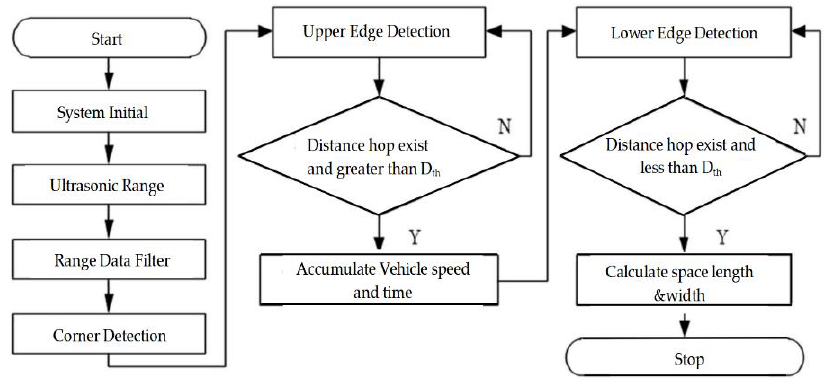
Figure 2. The structure of parking spot detection algorithm. Edge detection, which is crucial for the accuracy of parking spot detection, comprises upper edge detection and lower edge detection. In the case of parallel parking, the threshold of distance hop, which includes the hop threshold of the upper H upper and lower H lower edges, is calculated based on the threshold of the ultrasonic sensors D th and the cross range D cross between the target vehicle and parked vehicles, which is adjacent to the target parking spot. The threshold is determined by the width of the vehicle W vehicle and maximum range of the ultrasonic sensor D max